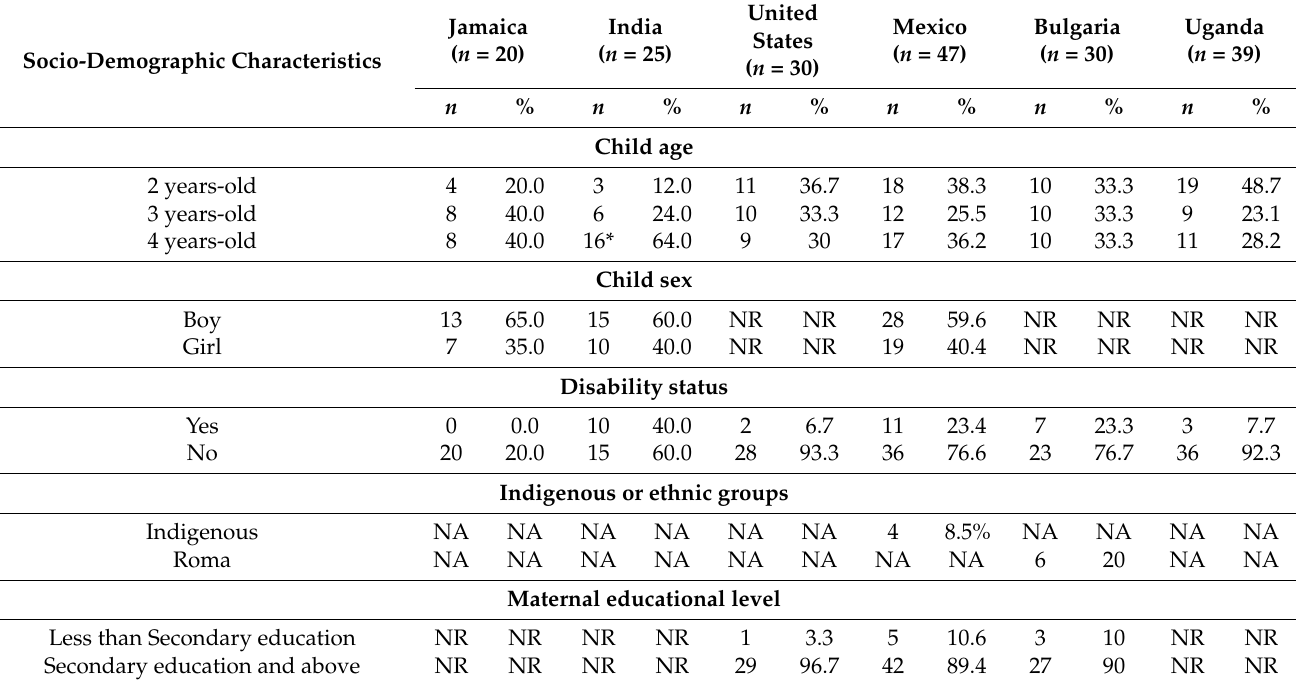
Table 1. Socio-demographic characteristics of respondents from Jamaica, India, the United States, Mexico, Bulgaria, and Uganda.